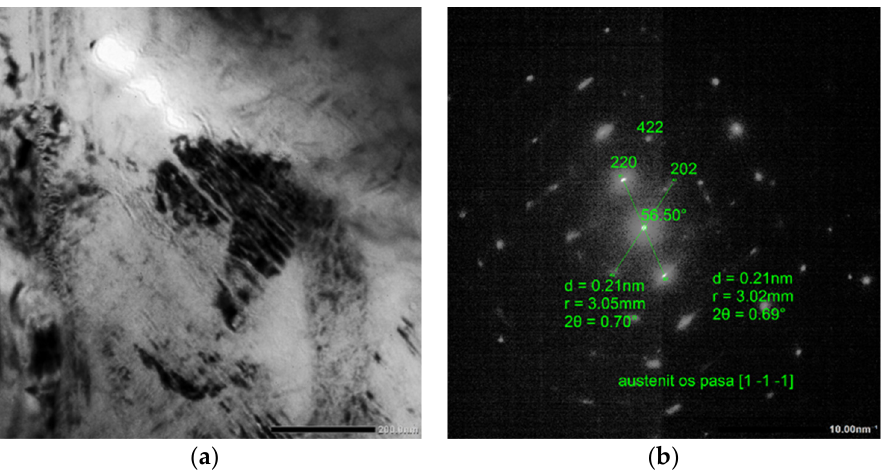
Figure 5. An image of the microstructure for variant 3; ( a ). Microstructure of grain with a bainitic ‐ martensitic (B + M) area visible inside with a very fine coniferous structure, image in a bright field magnification of 40 kx; ( b ). Electron diffraction from retained austenite in B + M island. The axis of the austenite belt [1 11 ]